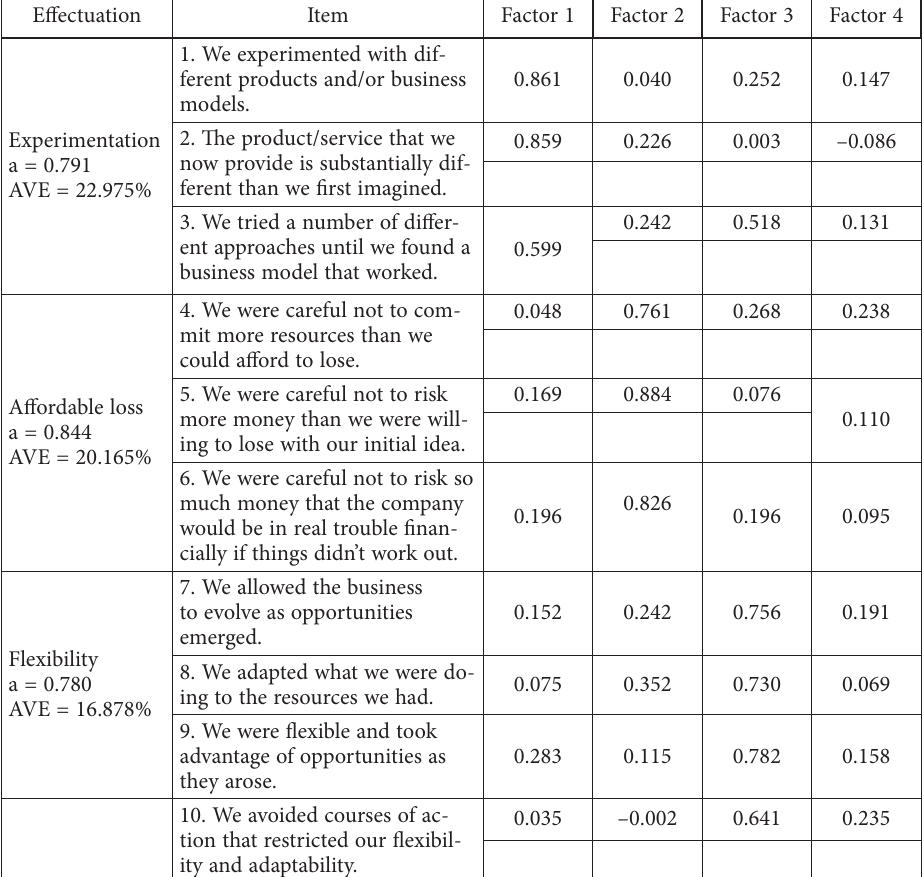
Table 2. The reliability and validity of effectuation